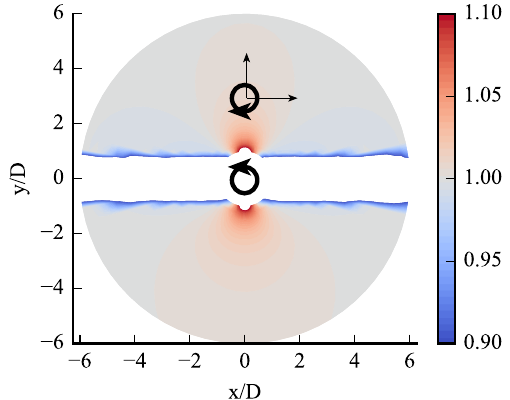
Figure 15. The first turbine is fixed in the center, and the second turbine is moved around in concentric circles with the wind incom- ing from the left. The contours show the normalized power of the two turbines (sum of their power normalized by sum of their power in isolation). The color scale is centered on 1.0 so that regions of beneficial interference can be more clearly seen. The color scale fo- cuses on a small region (0.9–1.1) for the same reason. The blank areas are waked regions, in which the power drops below the range of the color scale and so are not plotted.